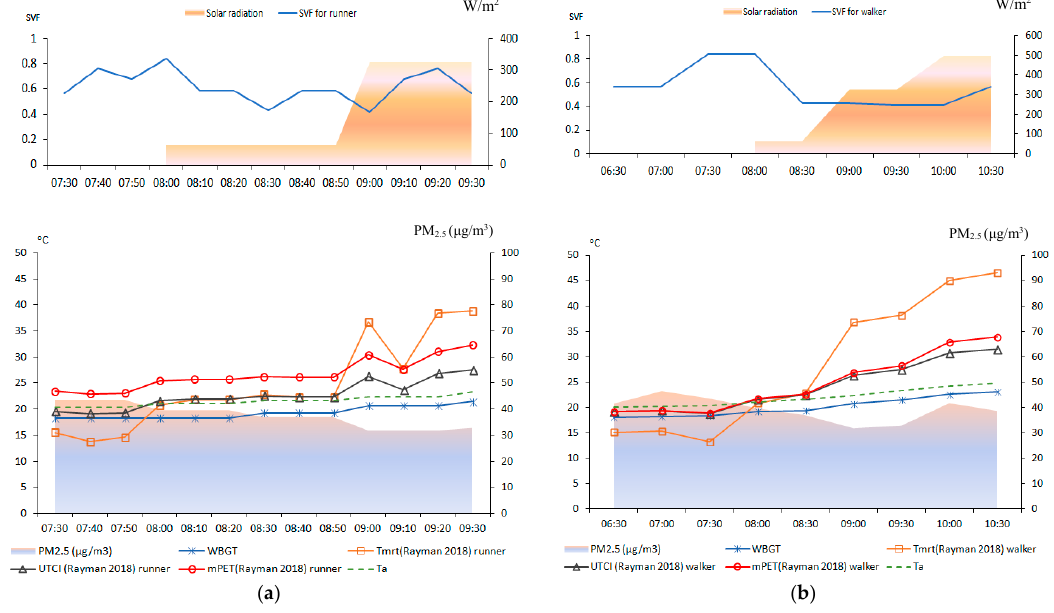
Figure 11. Winter running event thermal and environmental conditions for runners ( a ) and walkers ( b ).